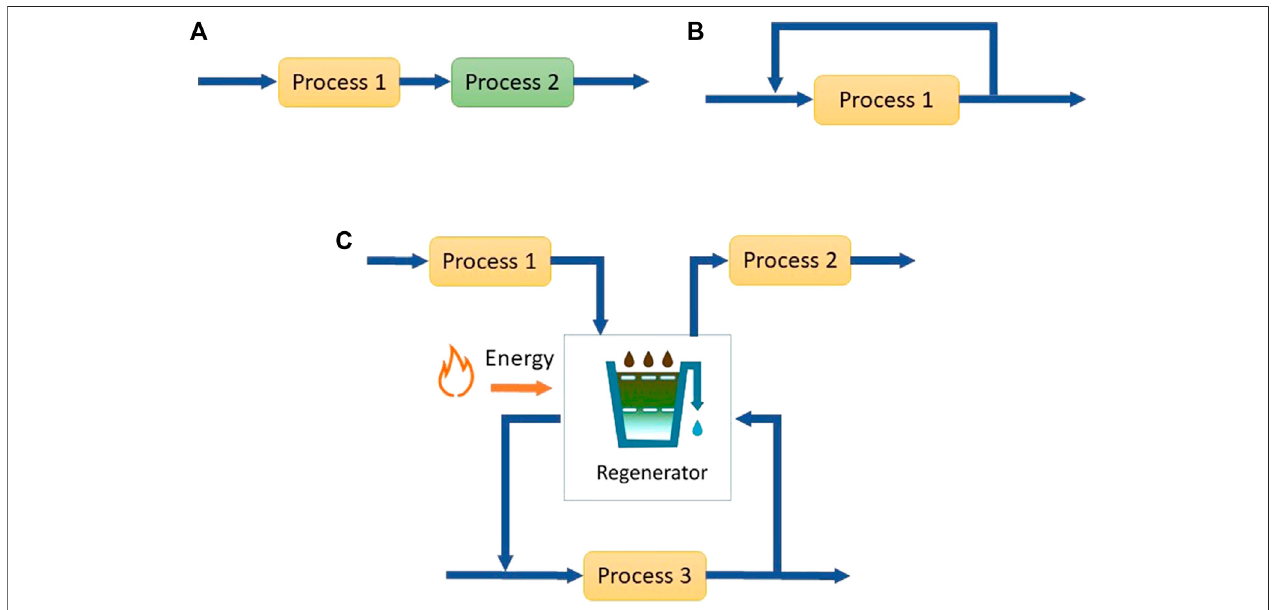
FIGURE 1 | (A) Reuse of water from process 1 in process 2 (B) Recycle of water from process 1 (C) Regeneration reuse from process 1 to 2 and regeneration recycle in process 3.